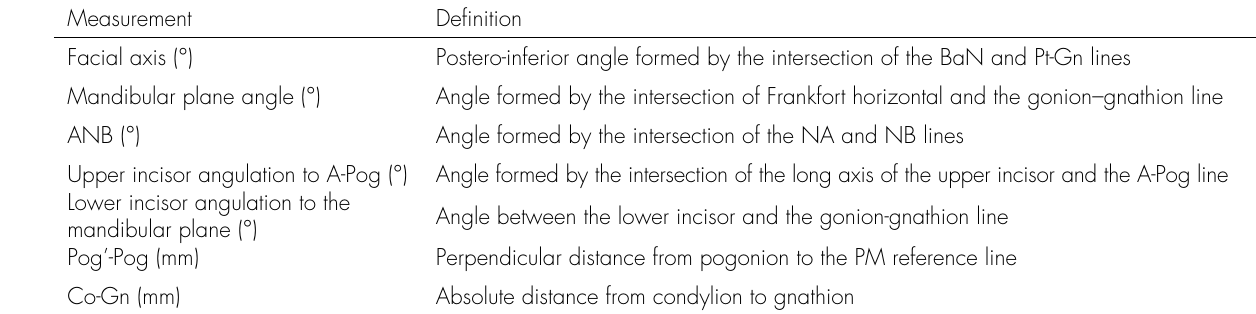
Table I. Cephalometric measurements used in this study.